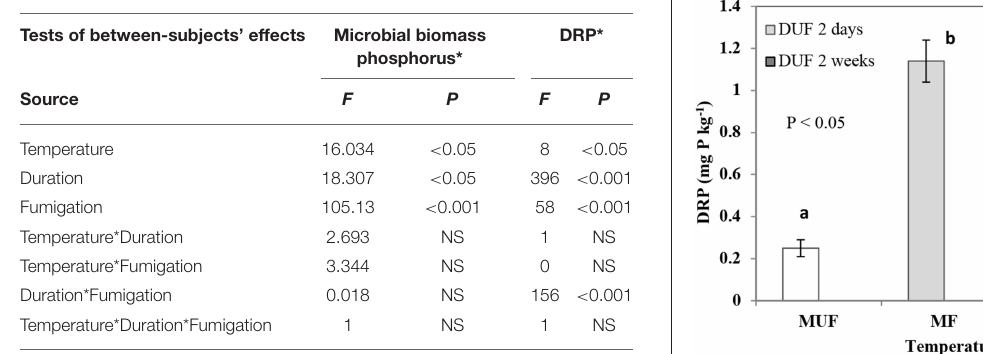
TABLE 3 | Summary statistics of three-way ANOVA.